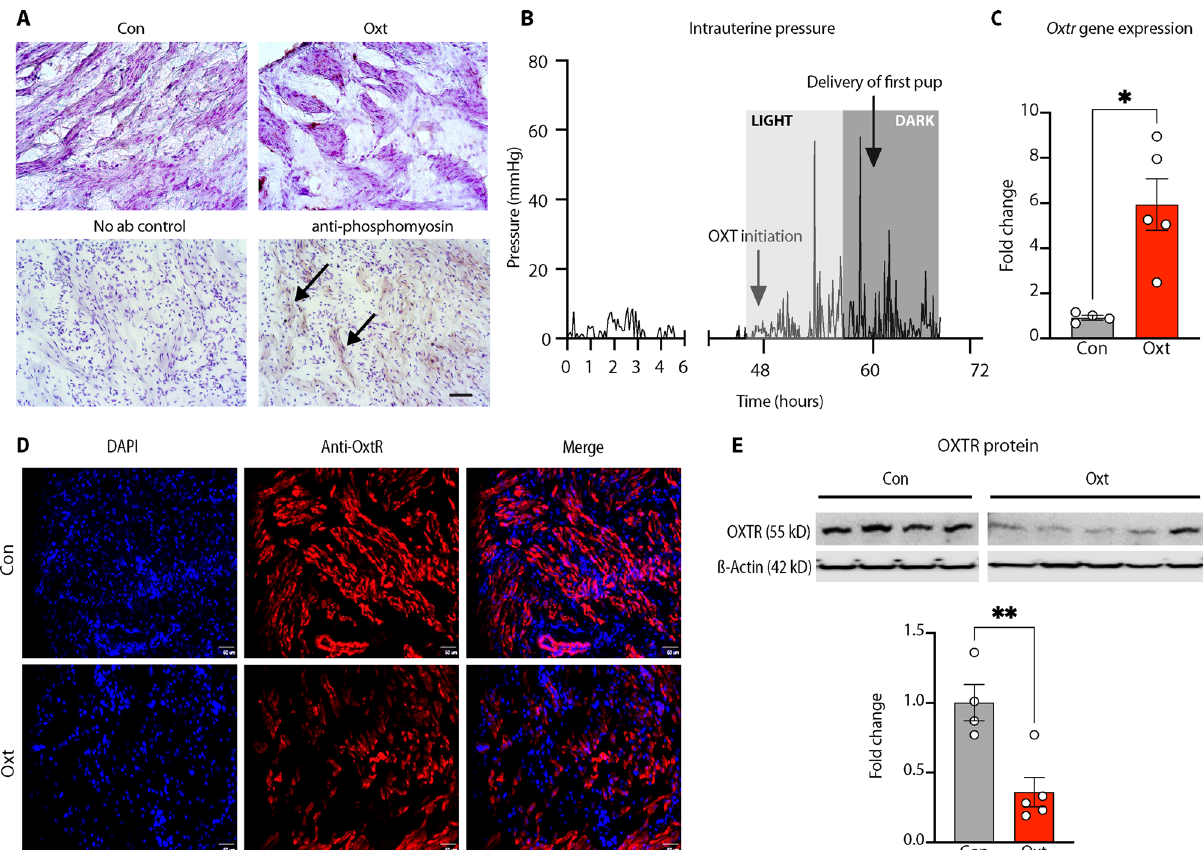
Figure 3. Validation of the model for labor induction with oxytocin. ( A ) Visualization of uterine contraction. Upper panel: uterine myometrium harvested from pregnant E21 rats at least 8 h after either saline (control) or intravenous Oxt infusion and stained with hematoxylin. 20 × photomicrographs showing lack of clustering of uterine myocytes in saline-treated myometrium (left) compared to extensive clustering in the Oxt-exposed myometrium (right). Lower panel: 5-μm frozen sections from Oxt-exposed myometrium stained without (left) or with rabbit anti-mouse phosphomyosin light chain kinase showing prominent staining among clustered uterine myocytes revealed with anti-rabbit HRP conjugate (marked by arrows) (right). Nuclei counterstained with hematoxylin. Scale bar = 100 μM. ( B ) Labor induction with Oxt causes cyclical increases in intrauterine pressure. Labor was induced with Oxt at 48 h after pump implantation (around 12 noon, light cycle, E20) and intrauterine pressure changes were monitored with telemetry. Oxt initiation was associated with acute and cyclical increases in intrauterine pressure until birth (first pup delivered around 21:00 h, dark cycle, E20). Light and dark cycle from 07:00–19:00 and 19:00–07:00, respectively. ( C ) Labor induction with Oxt was associated with a significant increase in OxtR gene expression at 8–12 h. ( D ) Labor induction with Oxt decreases OxtR immunoreactivity in the rat uterus. Sample 20 × photomicrographs from 5-µm sections of the uterine myometrium stained with goat anti-rat OxtR antibody (1:100) and revealed with Alexa Fluor® 594 labeled rabbit anti-goat antibody (1:300). Note naïve uterine myometrium with bright staining for OxtR in the upper panel, in sharp contrast to Oxt-exposed myometrial tissue in the lower panel where staining was scant, suggesting downregulation of OxtR. Scale bar = 50 μM. ( E ) Representative cropped western blot images showing a decrease in membrane associated OxtR protein expression after labor induction with Oxt and quantified with densitometry. Full length blot is presented in Supplementary Figure S3. Please note that the Oxt and Con lanes have been cropped and reversed to present the data in a manner consistent with the rest of the manuscript (i.e., Con followed by Oxt data). Data analyzed with Welch’s t-test and presented as mean ± SEM; * p ≤ 0.05, ** p ≤